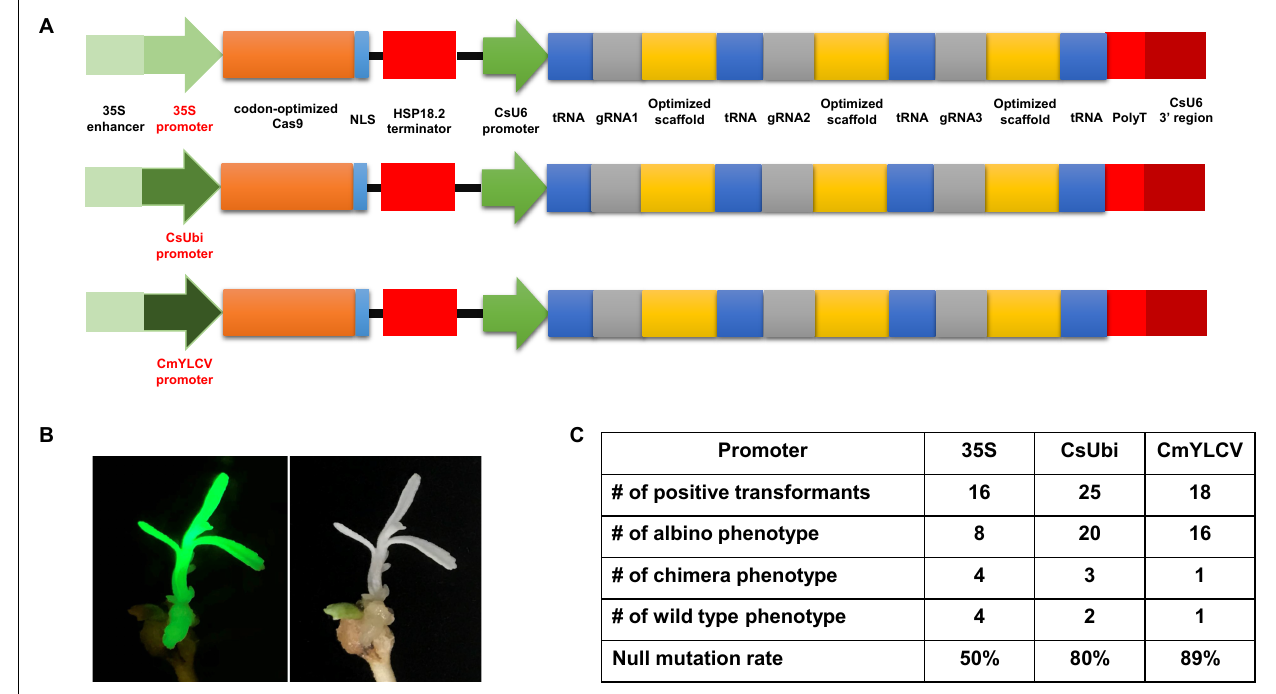
FIGURE 1 | Optimal promoters for driving Cas9 expression to improve gene editing efficacy in citrus. (A) 35S promoter, citrus ubiquitin promoter (CsUbi), and Cestrum yellow leaf curling virus (CmYLCV) promoter for driving Cas9 expression in the CRISPR constructs. (B) A representative picture showing albino phenotype, caused by null mutation of the PDS gene with CmYLCV promoter construct. The construct contains GFP as visual marker. (C) Summary of editing efficacy from three constructs shown in (A) .